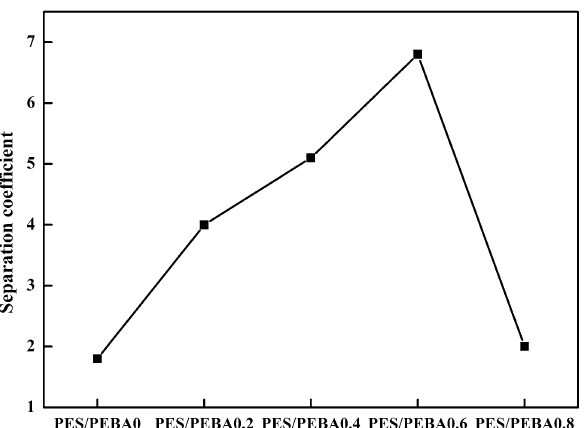
Figure 8. Gasoline vapor separation coefficient of modified PEBA membranes with different fumed silica